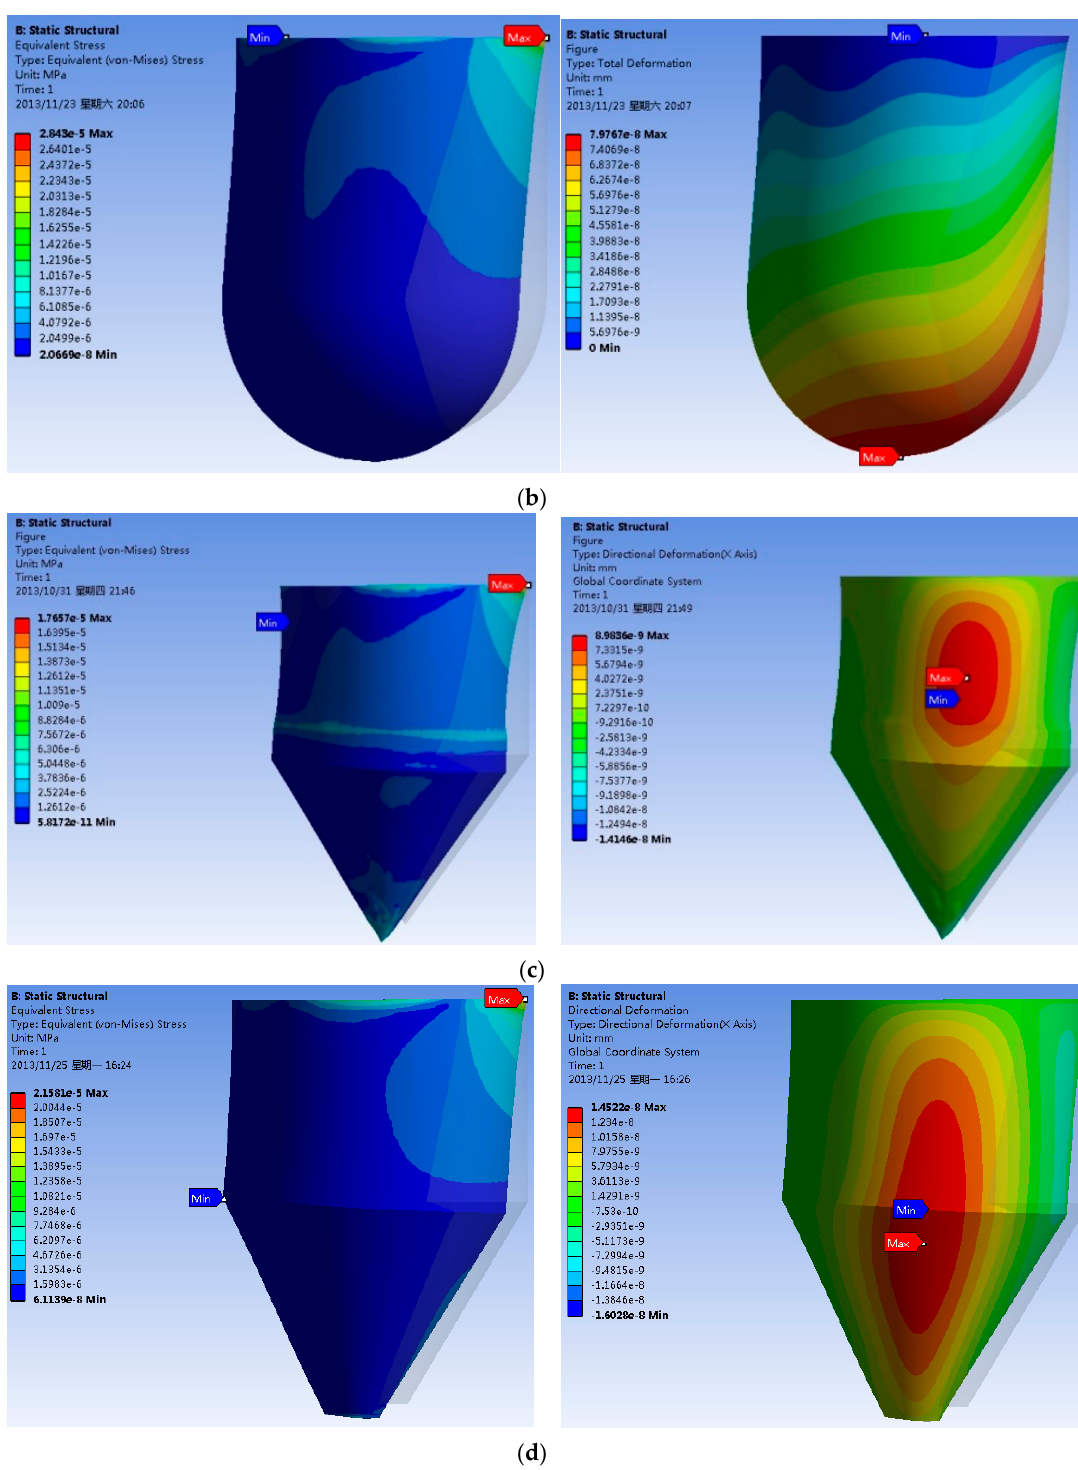
Figure 4. Von Mises stress and deformation of four types of buoys. ( a ) cylindrical buoy; ( b ) cylinder-hemisphere combined buoy; ( c ) turbinate buoy with point tip; ( d ) turbinate buoy with tip radius at 0.2 m.